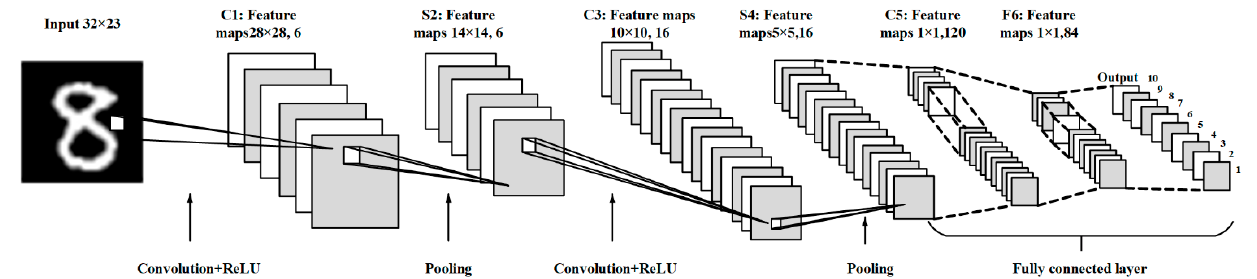
Figure 3. The proposed CNN model structure.